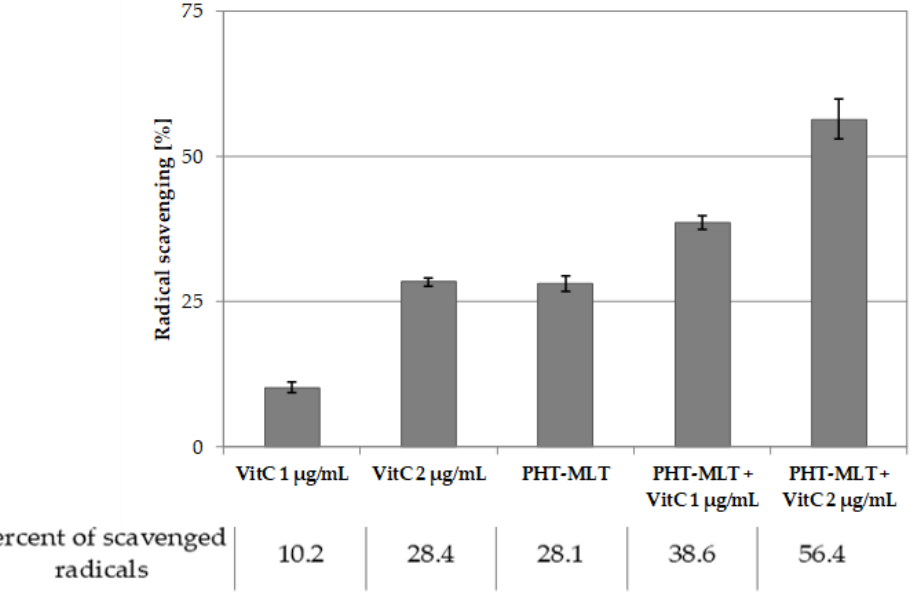
Figure 2. The percentage radical inhibition calculated for SNT-MLT and PHT-MLT alone and in combination with 1 and 2 µ g/mL ascorbic acid solution (AsA); graph presents mean absorbance intensity for 30 min time point; the data on graphs show mean values ± SD that are representative for three experiments; n = 3.